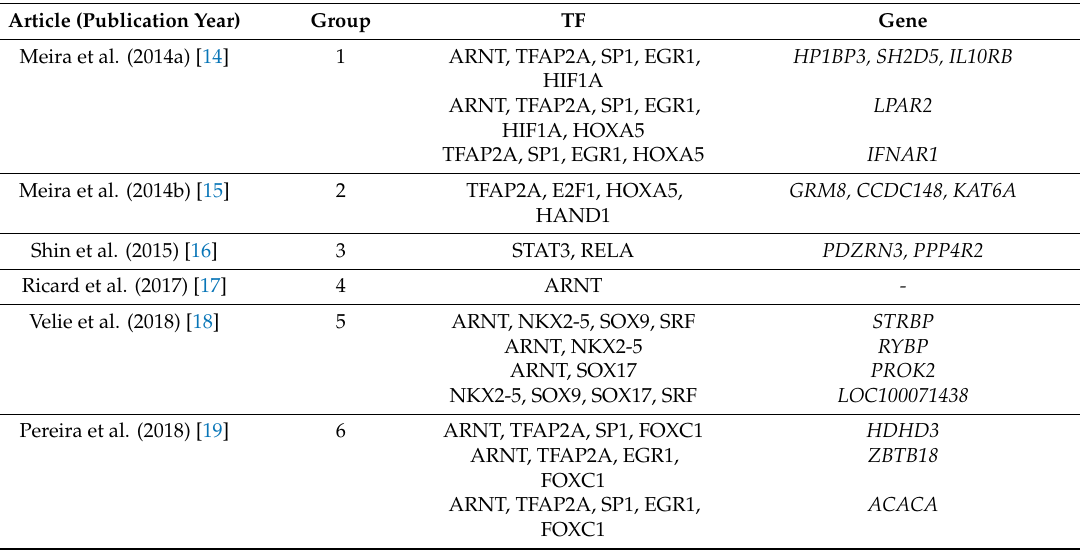
Figure 3. Horse performance gene–transcription factor (TF) network, focus 2. Rounded square nodes represent the TFs, wherein four main TFs are highlighted: NKX2-5, SRF, SOX17 and SOX9. Blue nodes are associated with genes from group 5, whereas the one with two colors (orange and blue border) is associated with groups 7 and 5, respectively. Gray nodes are the identified candidate genes, whereas the main candidate genes related with horse performance are represented by light pink color. Table 3. Genes highlighted in gene–TF network and their respective TFs and group.